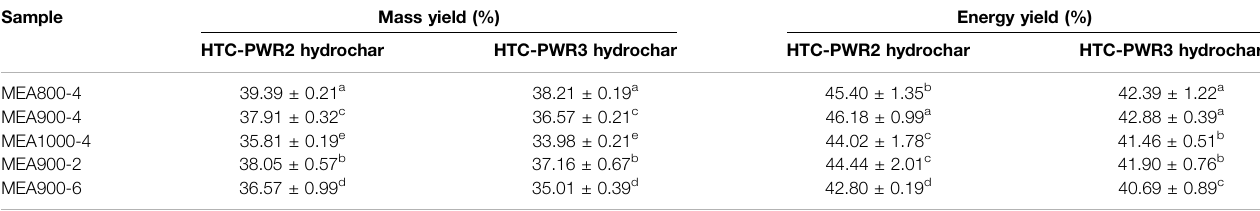
TABLE 4 | The mass and energy yields of wheat straw hydrochar after microwave energy